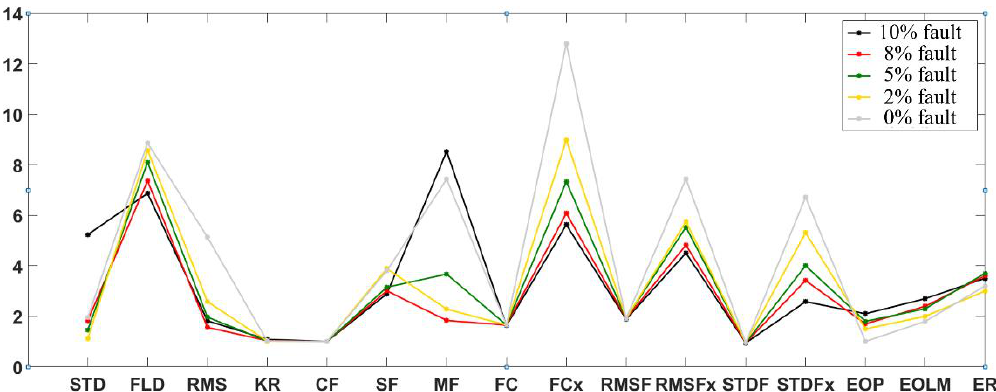
Figure 9. Feature comparison of the yaw angle signal for weak fault severity.